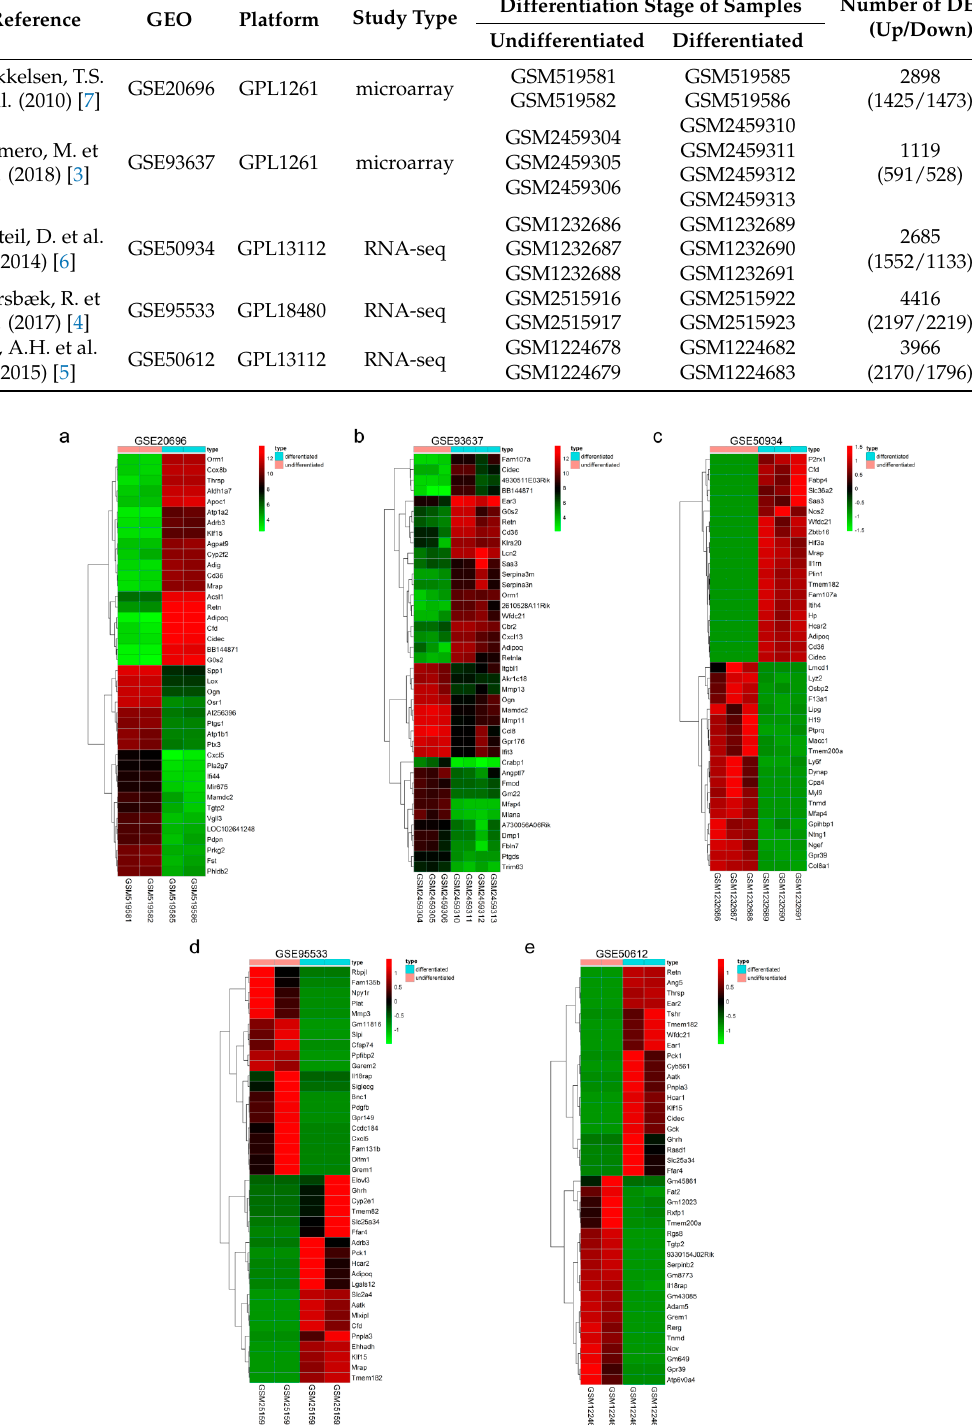
Figure 1. Hierarchical clustering heatmap of the top 20 up- and down-regulated differentially expressed genes (DEGs) screened in each Gene Expression Omnibus (GEO) dataset. ( a ) GSE20696 data, ( b ) GSE93637 data, ( c ) GSE50934 data, ( d ) GSE95533 data, and ( e ) GSE50612 data. Each row represents one gene, and each column represents one sample. Red indicates that the expression of genes is relatively upregulated, and green indicates that the expression of genes is relatively downregulated.